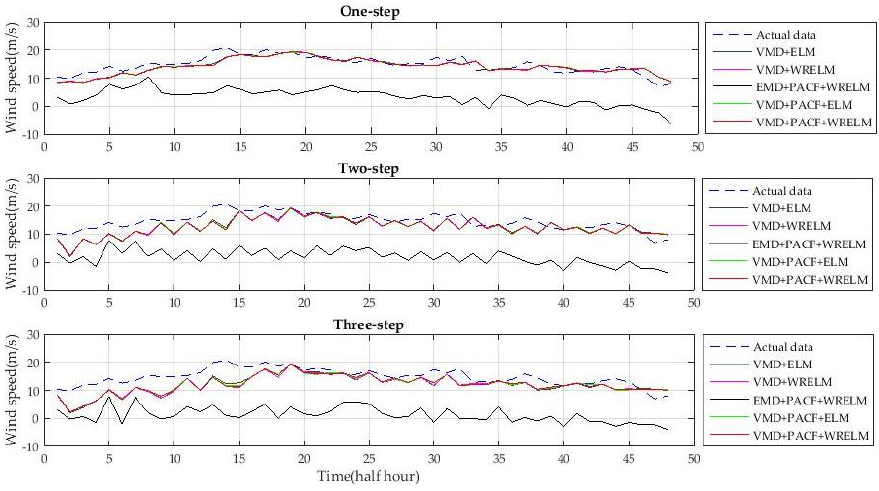
Figure 13. Forecasting results on 20 August 2004, using different methods.